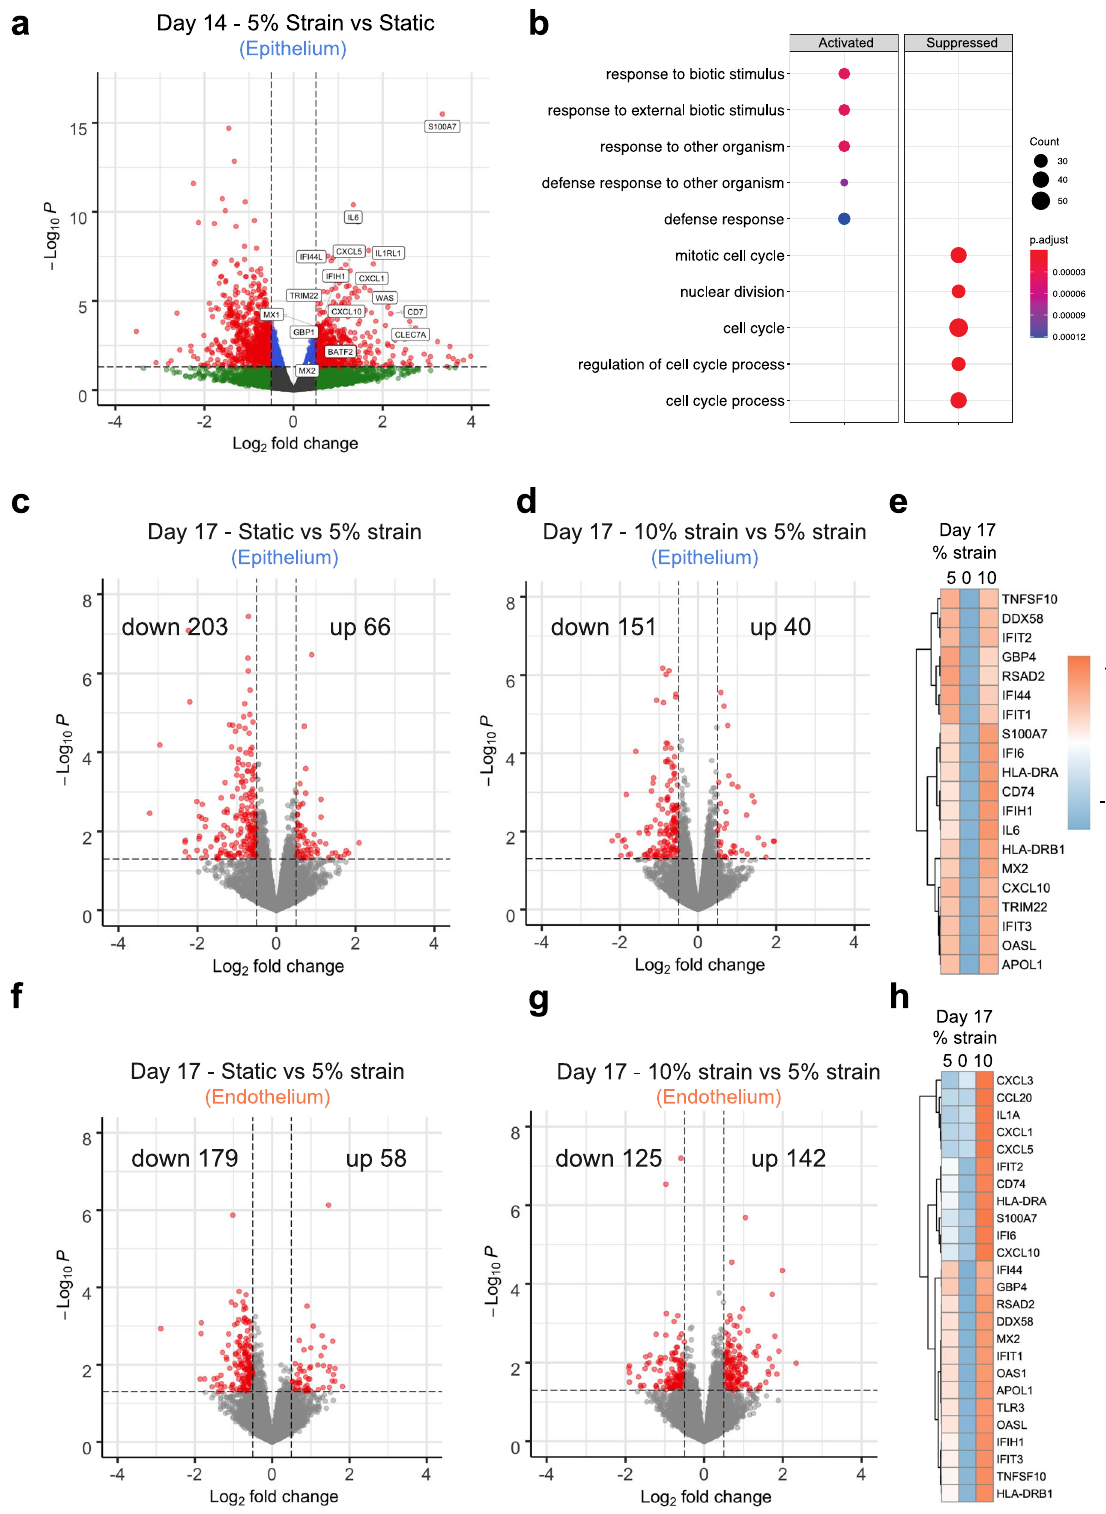
in the lung sustain higher levels of antiviral innate immunity in both lung alveolar epithelial cells and pulmonary micro- vascular endothelial cells compared cells cultured in the same chips under static conditions, which helps to explain why viral infection ef fi ciency is reduced in the mechanically strained alveolus